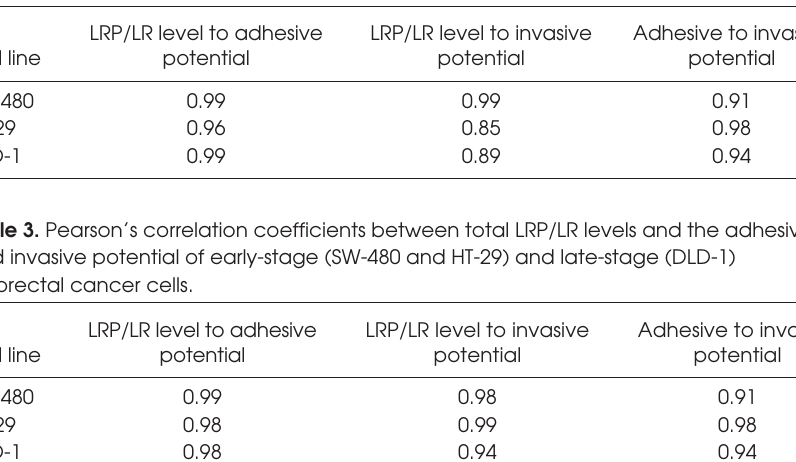
All MFI values represent an average of experiments performed in triplicate. Table 2. Pearson’s correlation coefficients between cell surface LRP/LR levels and the adhesive and invasive potential of early-stage (SW-480 and HT-29) and late-stage (DLD-1) colorectal cancer cells.